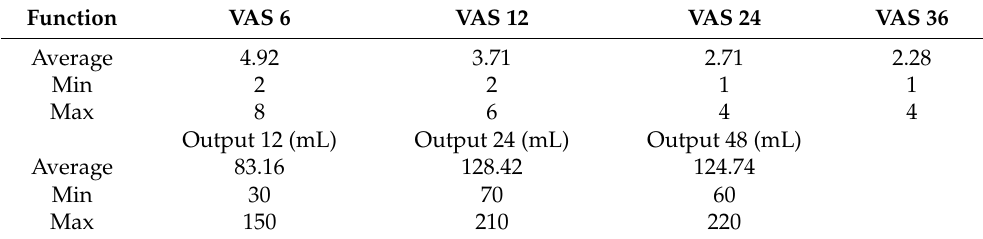
Table 7. An analysis of the VAS dynamics and amount of drain fluid for Group B.